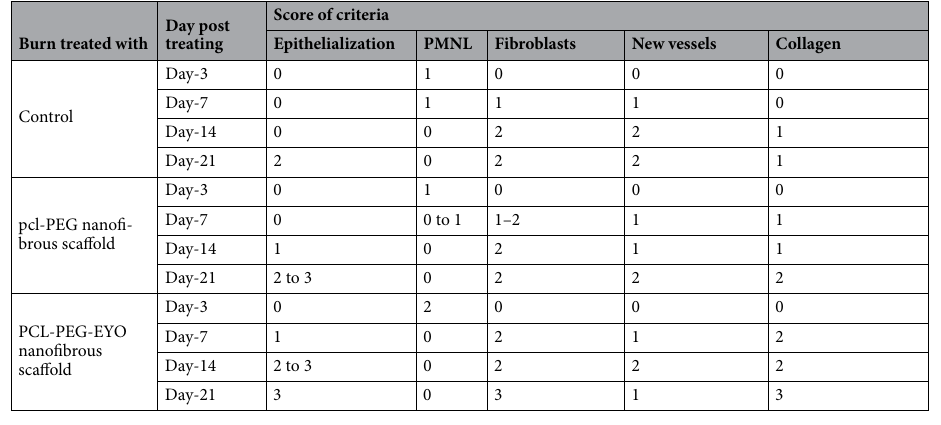
Table 2. Results of scored criteria based on Table S1 according to the results of Fig. 5B and Fig.